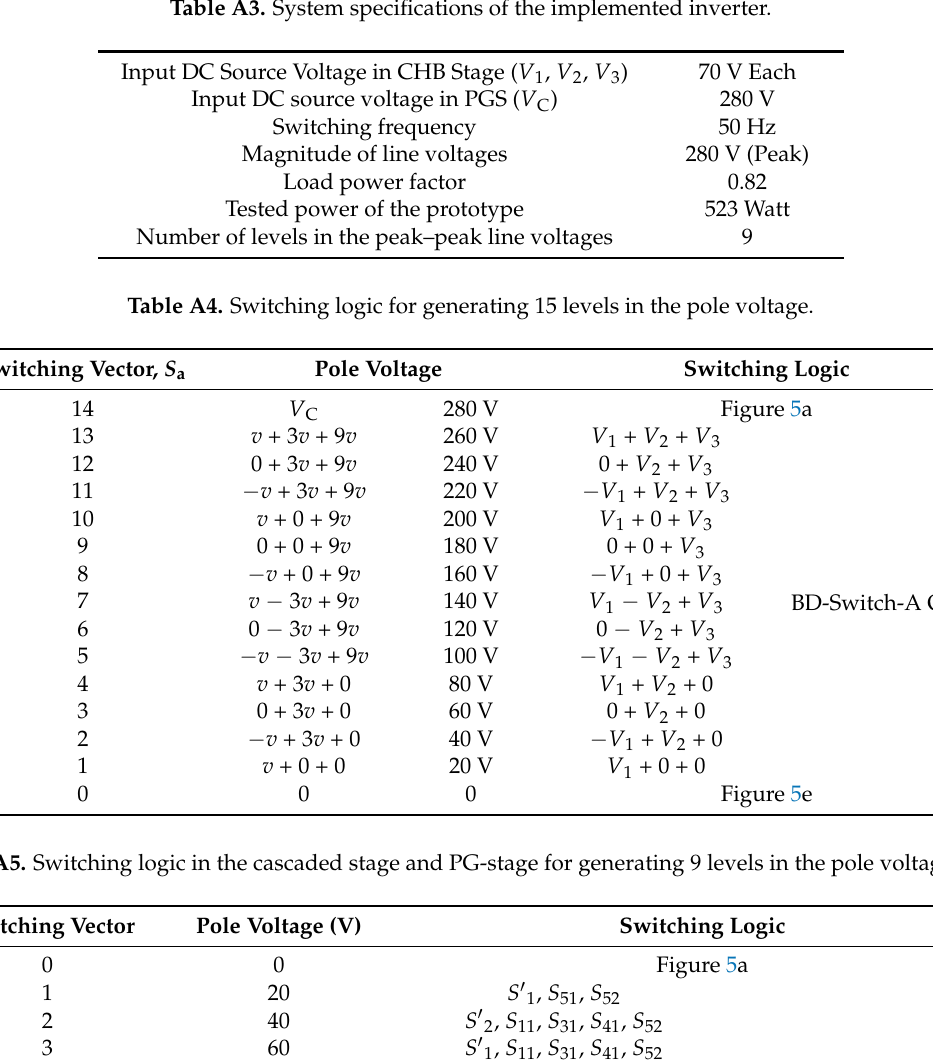
Table A3. System specifications of the implemented inverter.